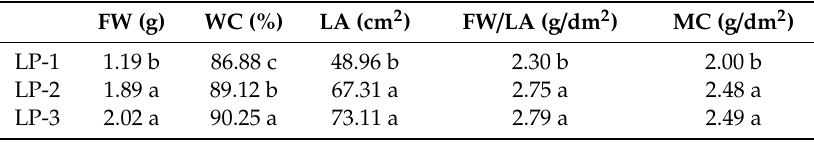
Table 1. Characteristic differences of the tomato leaves according to height layers.